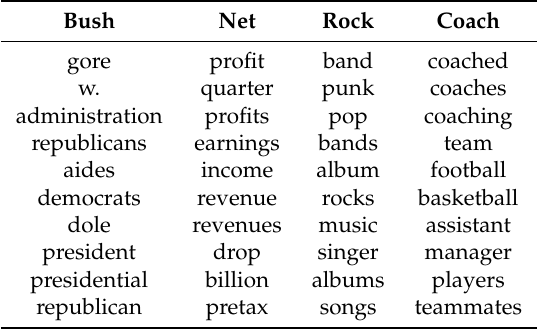
Table 3. Concepts can show a mismatch in meaning between the visual concept in Broden and its corresponding embedding in GloVe. The top row concept is from Broden, the other concepts are neighbors from GloVe. Bush is related to vegetation in Broden while in GloVe it is related to the American president, net is related to, e.g., a volleybal net while in GloVe it is related to money and business, rock is related to geology in Broden while in GloVe it is related to music and coach is related to transportation in Broden while in GloVe it is related to